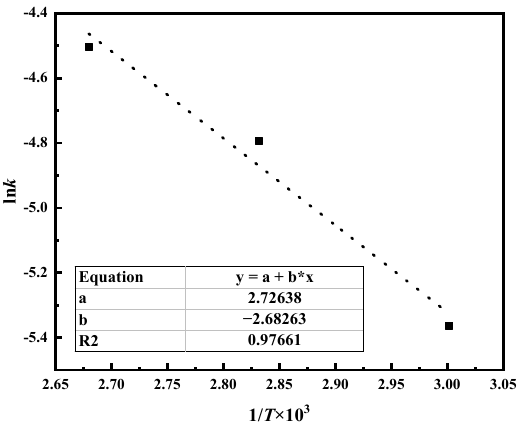
Figure 11. Reaction activation energy regression curves of internal diffusion.